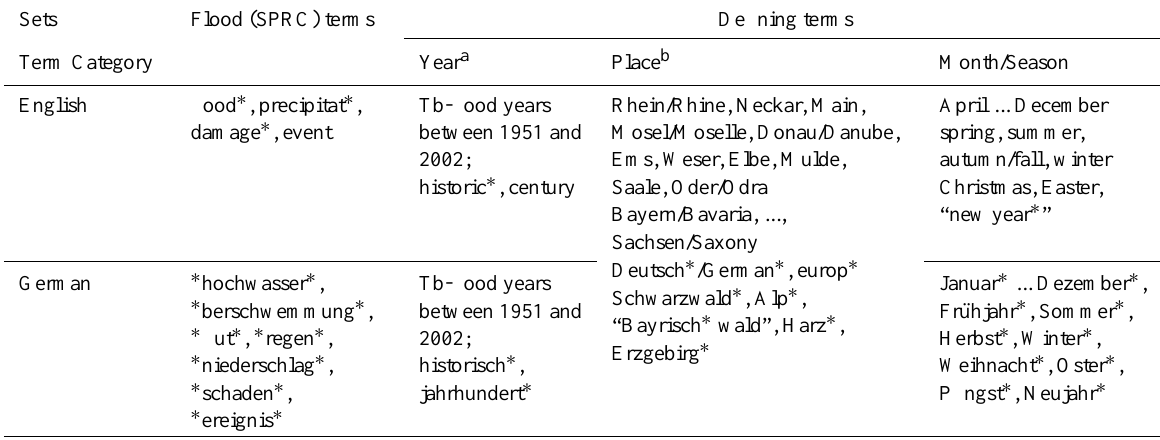
Table 1. List of search terms.